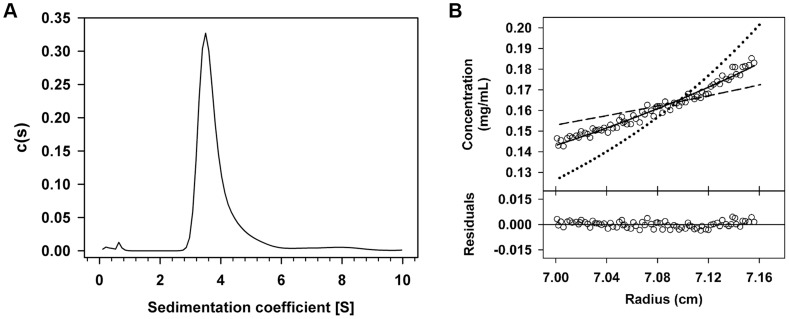
RcoLS20 forms tetramers in solution.The oligomerization state of RcoLS20 protein in solution was studied by two complementary analytical ultracentrifugation assays. A. Sedimentation velocity assay. Sedimentation coefficient distribution c(s) profile corresponding to 10 µM purified RcoLS20. B. Sedimentation equilibrium assay. Upper part: Sedimentation equilibrium data for RcoLS20 (empty circles) are presented together with best-fit analysis assuming protein dimer (dashed line), tetramer (black line), or octamer (dotted line) species. The data indicate that RcoLS20 is a tetramer at 10 µM. Lower part: The difference between estimated values and experimental data for protein tetramers (residuals).